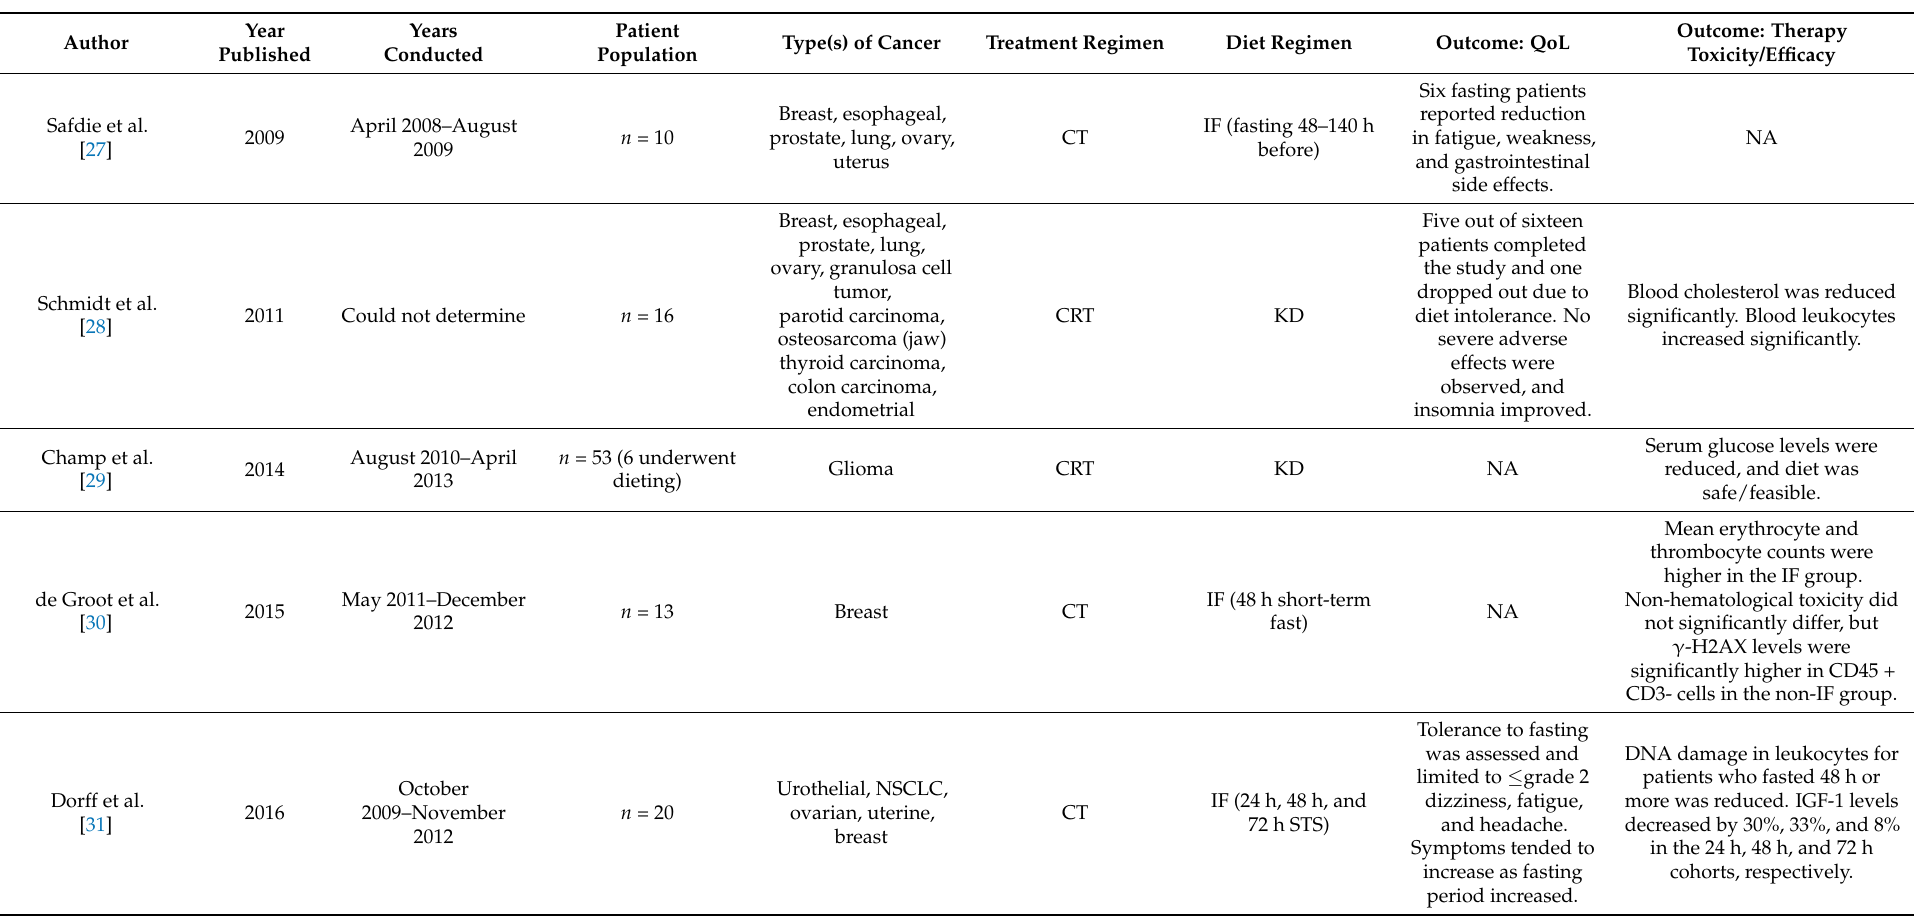
Table 1. Clinical studies examining the effect of dietary interventions (CR, IF, and KD) in patients who were undergoing chemotherapy and/or